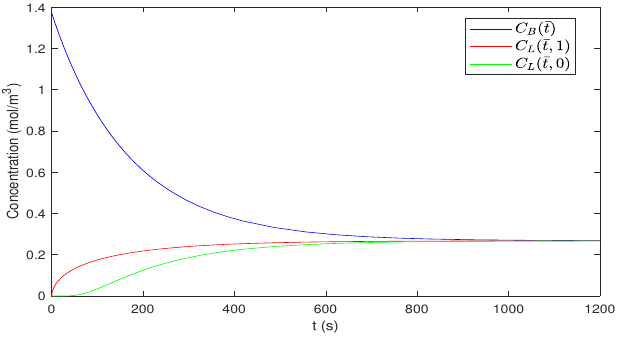
Figure 11. Dynamics of the concentrations obtained from the simplified model with Langmuir isotherm for the data reported in [16].